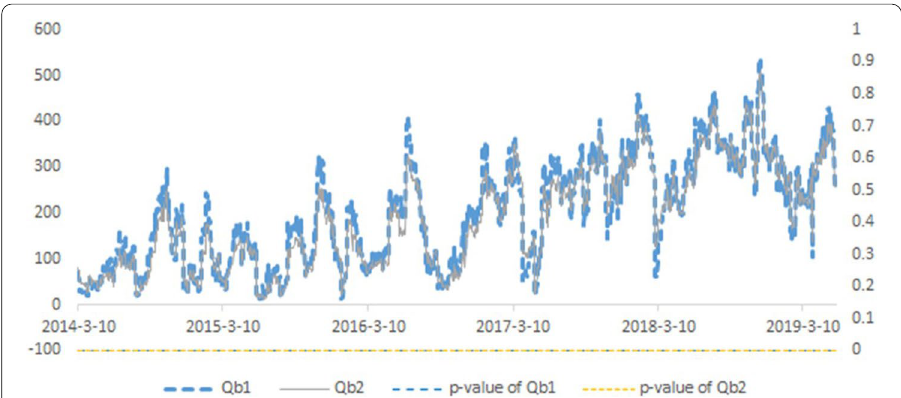
Fig. 8 Bidirectional time-varying Granger test between Trading Volume and internet attention (Qb1: trading volume < > GSVI; Qb2: trading volume < =